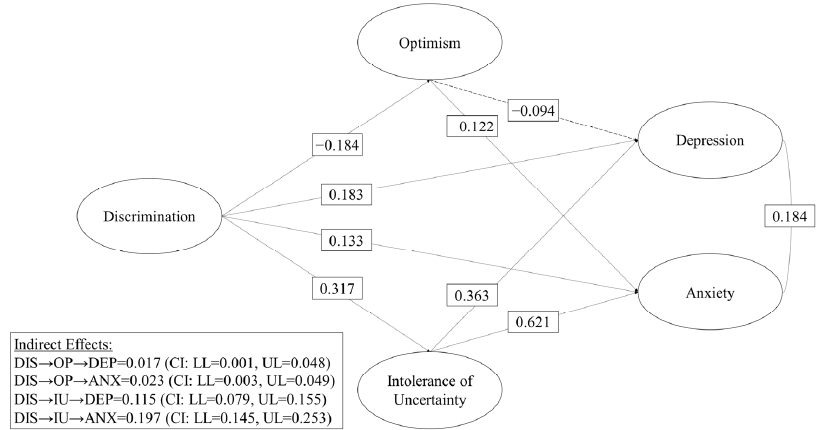
Figure 4. Model of the direct effects of discrimination, mediated by optimism and intolerance to uncertainty on depression and anxiety. Note: DIS = Discrimination; OP = Optimism; IU = Intolerance to Uncertainty; DEP = Depression; ANX = Anxiety; CI = Confidence Interval 95%; LL = Lower Limit; UL = Upper Limit. The analysis controlled for the effects of years of stay, city, gender, age and phenotype. Solid paths indicate significant relationships effects ( p < 0.05). Non ‐ significant paths are shown with a dashed line. All effects are